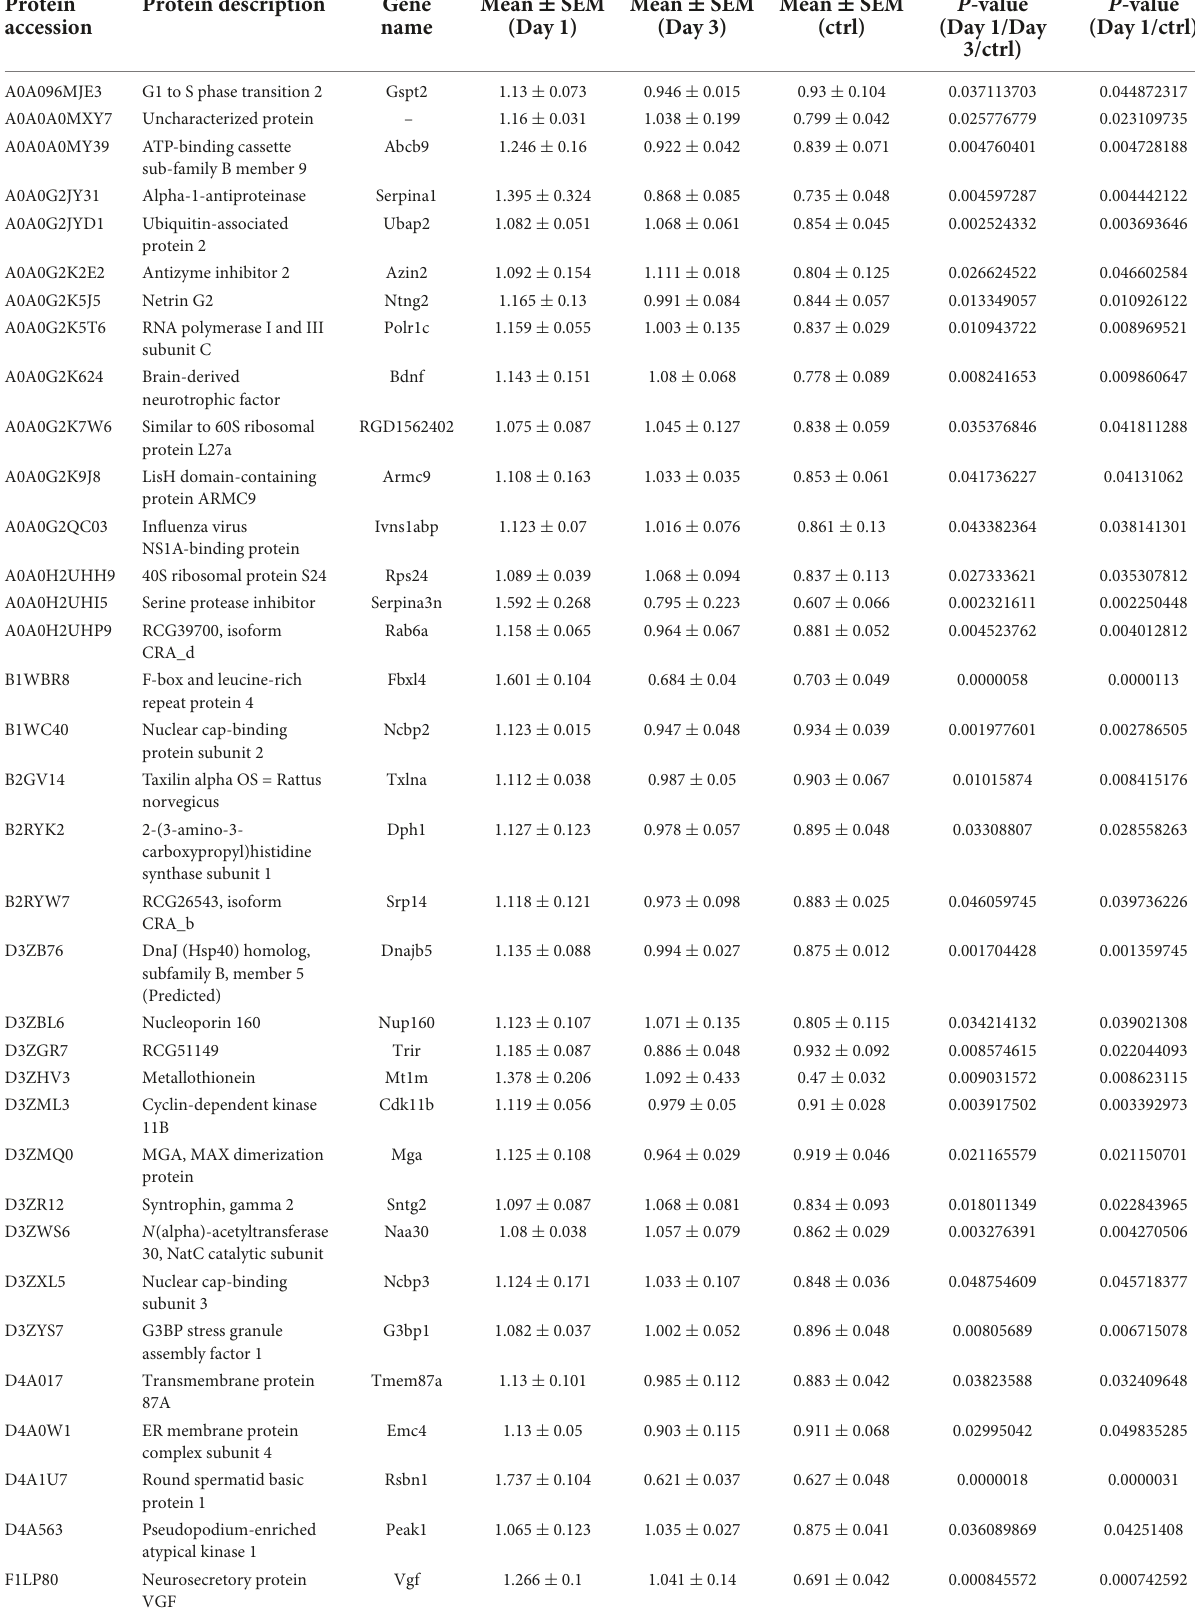
TABLE 1 Differentially expression proteins on Day 1 comparing with control (ctrl) in hippocampus post ANOVA analysis. Protein Protein accession